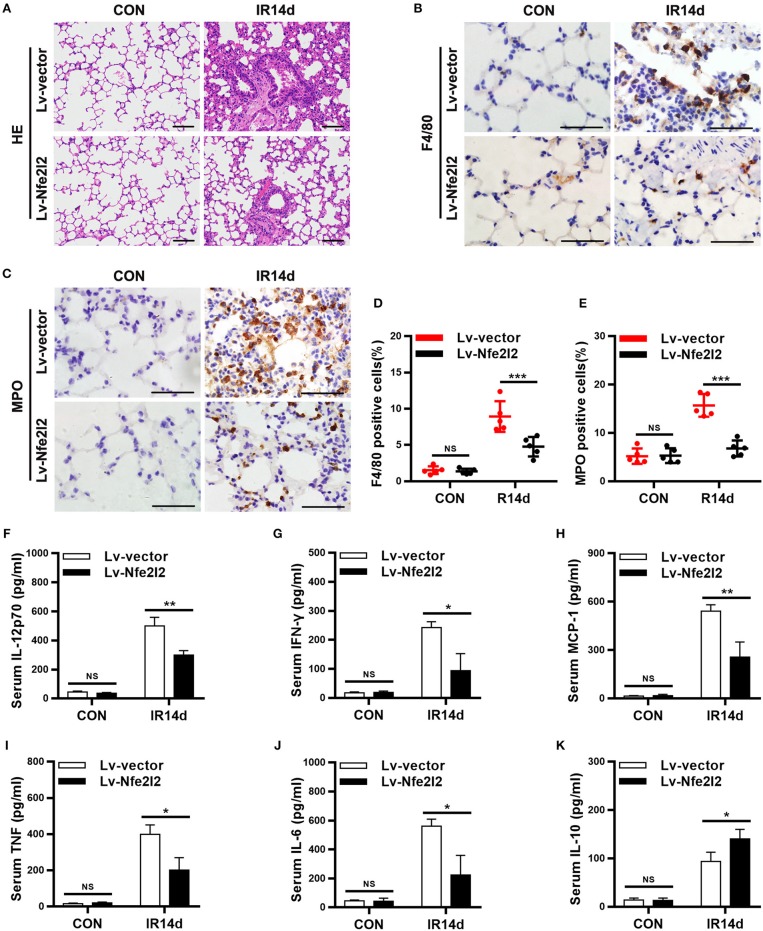
Nrf2 overexpression alleviates radiation-induced lung injury and inflammation. (A) Nrf2 overexpression attenuated radiation-induced lung injury as measured by HE staining. Scale bar: 100 μm. (B,D) Nrf2 overexpression decreased radiation-induced infiltration of macrophages as measured by immunohistochemistry staining. Scale bar: 50 μm. (C,E) Excess Nrf2 inhibited radiation-induced infiltration of neutrophils. Scale bar: 50 μm. (F–K) Nrf2 overexpression downregulated radiation-induced serum levels of pro-inflammatory cytokines (IL-12p70, IFN-γ, MCP-1, TNF, and IL-6) and increased radiation-induced serum levels of anti-inflammatory cytokines (IL-10). n = 5. NSRepresents no statistical difference (P > 0.05). *P < 0.05; **P < 0.01; ***P < 0.001. Every experiment was repeated for 3 times. The data was shown as mean ± SD and he representative figures were presented here.